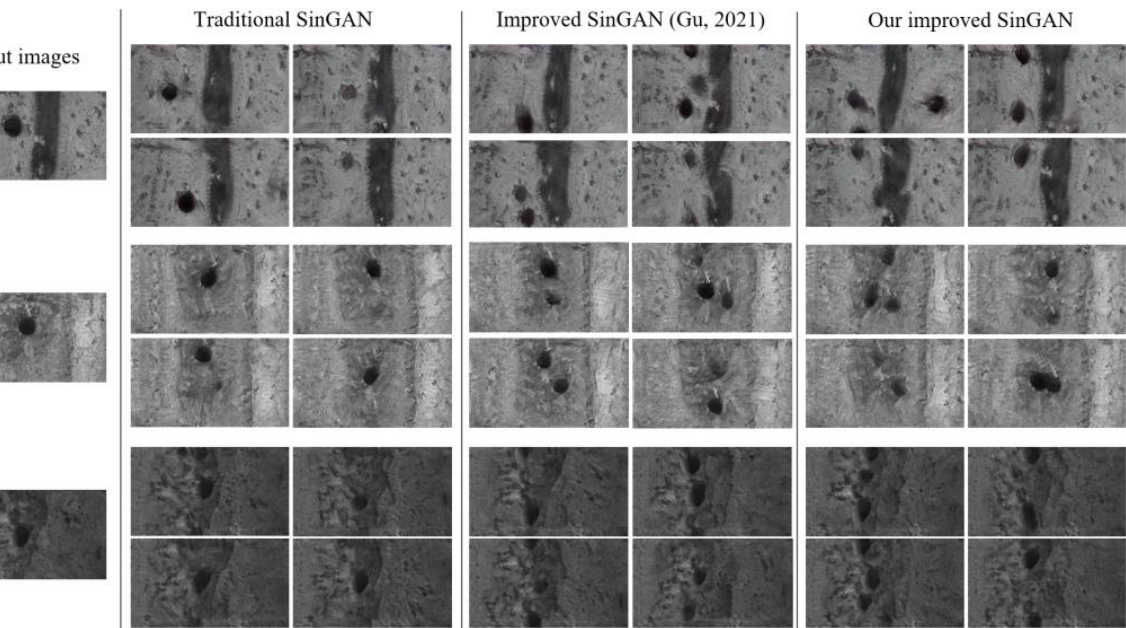
Figure 10. Images generation results based on traditional SinGAN, improved SinGAN in [25], and our improved